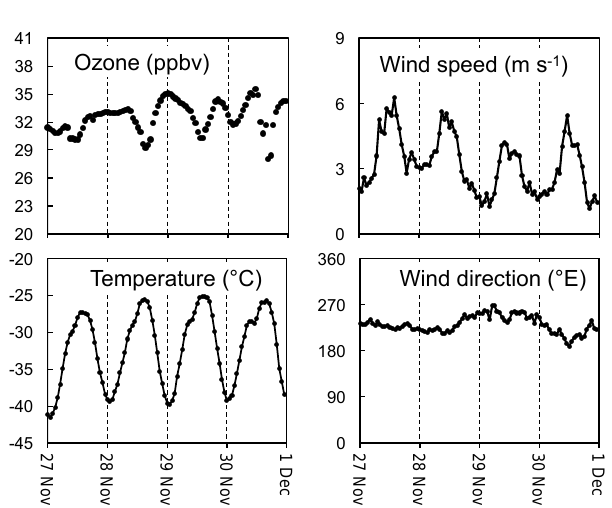
Figure 8. Hourly averaged surface ozone mixing ratio together with weather conditions at Concordia in summer over 4 days (27– 30 November 2009) characterized by stable continental conditions (see also Fig.